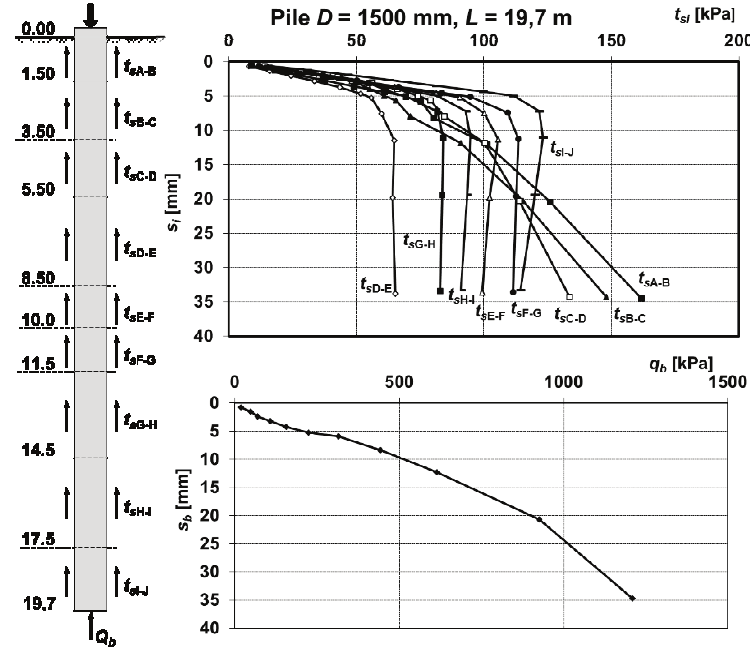
Fig. 8. Unit skin friction distribution t si [kPa] and unit load under the pile base q b [kPa] derived from numerical